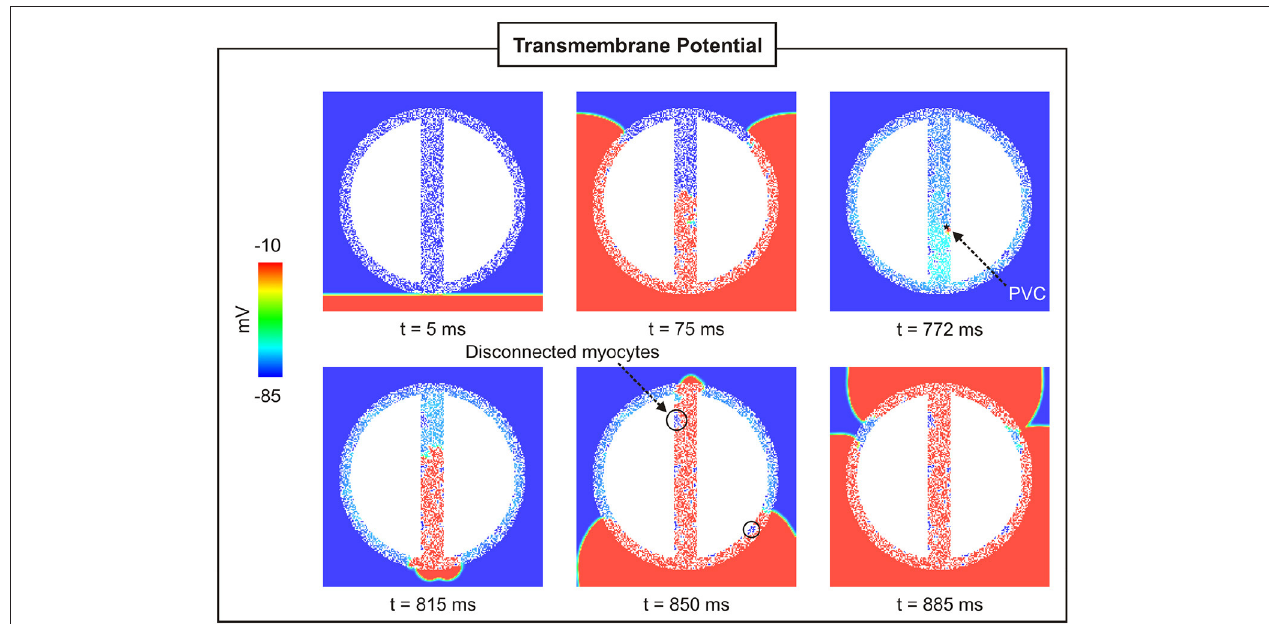
FIGURE 7 | PVC formation in a 2D sheet with w isth = 4mm and FIB BZ = 50%. V m maps at different times showing a paced beat ( t = 5ms) followed by a PVC ( t = 772ms) in the